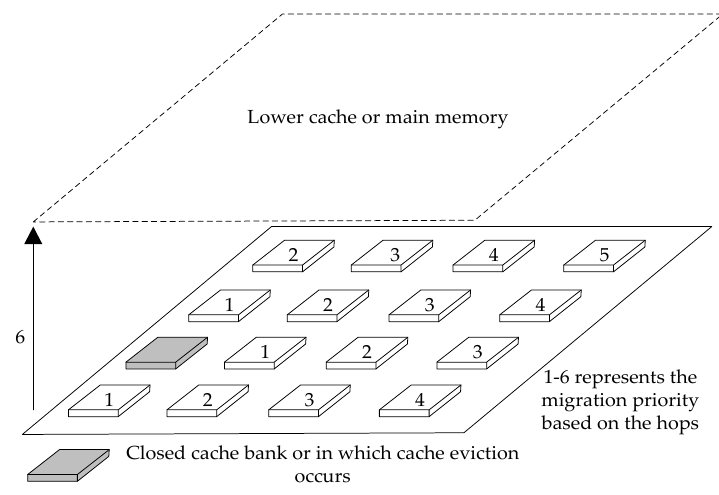
Figure 6. The optimization in migration.